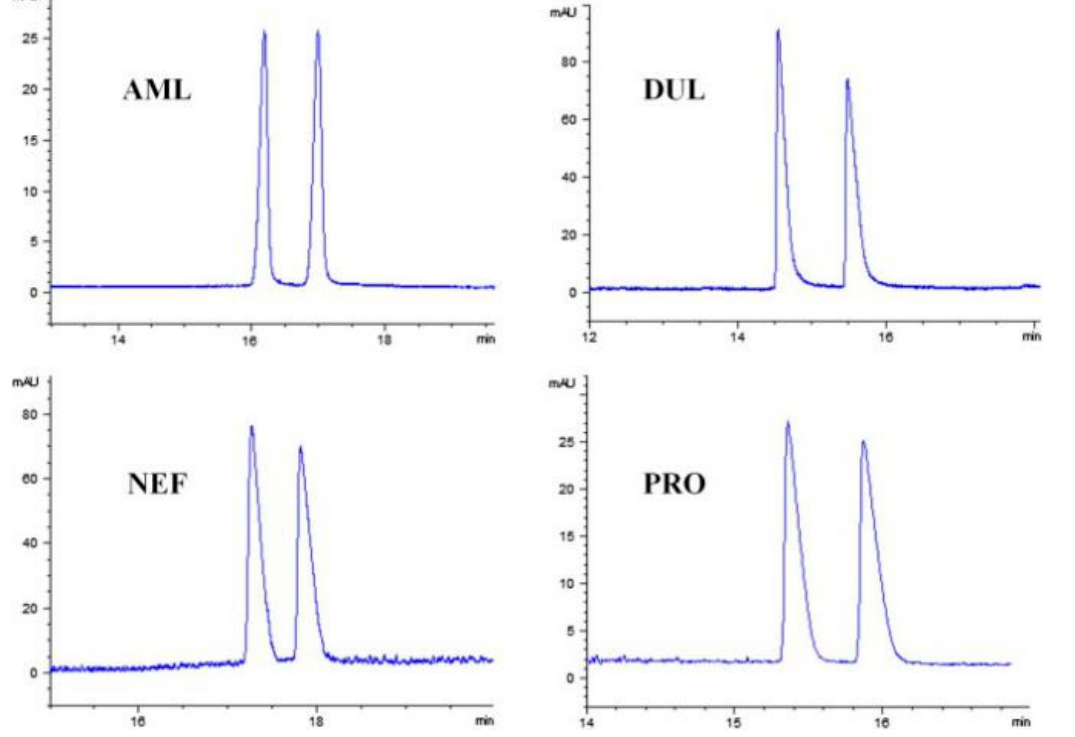
Figure 11. Chiral separation of all drug enantiomers in the optimized HP- β -CD / TMA-L-Arg synergic system. Conditions: focused-silica capillary, 50 cm (41.5 cm effective length) × 50 µm i.d; applied voltage, 20 kV; capillary temperature, 15 °C; BGE, 40 mM Tris/H 3 PO 4 buffer solution (Ph 2.6) containing 20 mM HP- β -CD/TMA-L-Arg. Figure adopted from [220] with copyright permission.